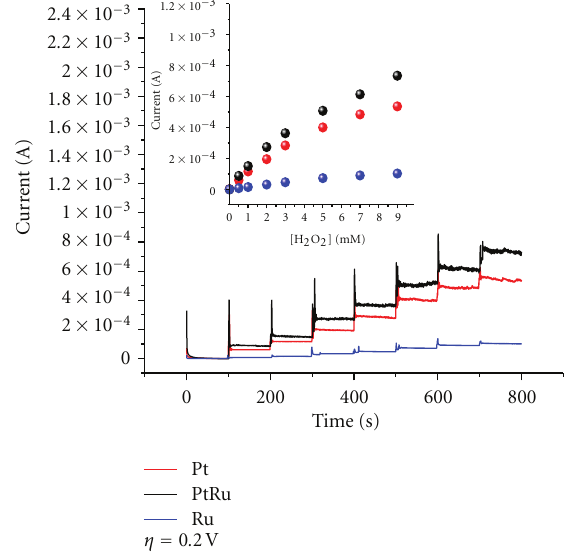
Figure 5: Amperometric curves and current-concentration rela- tionship (insert) of Pt (red), Pt-Ru (black), and Ru (blue) for H 2 O 2 injections at overpotential of +0.2V.